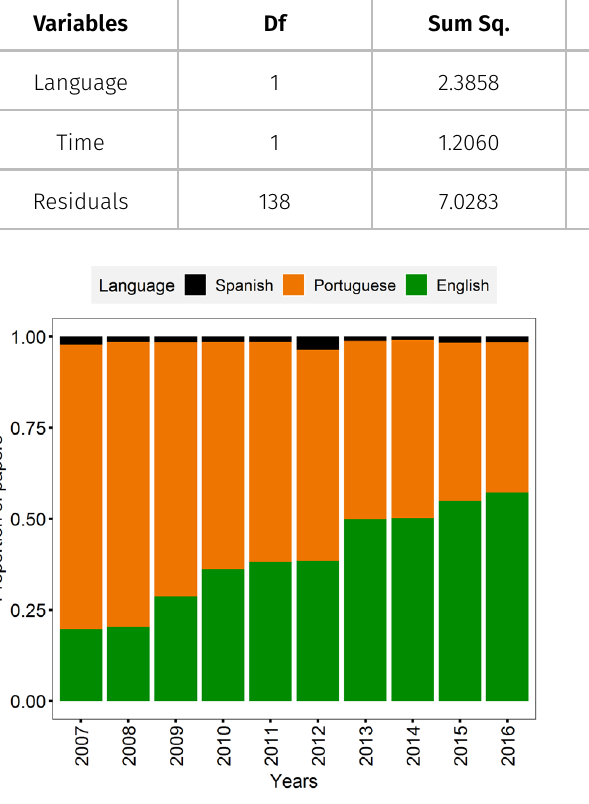
Figure 2. Annual changes in the proportion of papers published in different languages in multilanguage journals. Along the years, multilanguage journals tended to publish more papers in English.